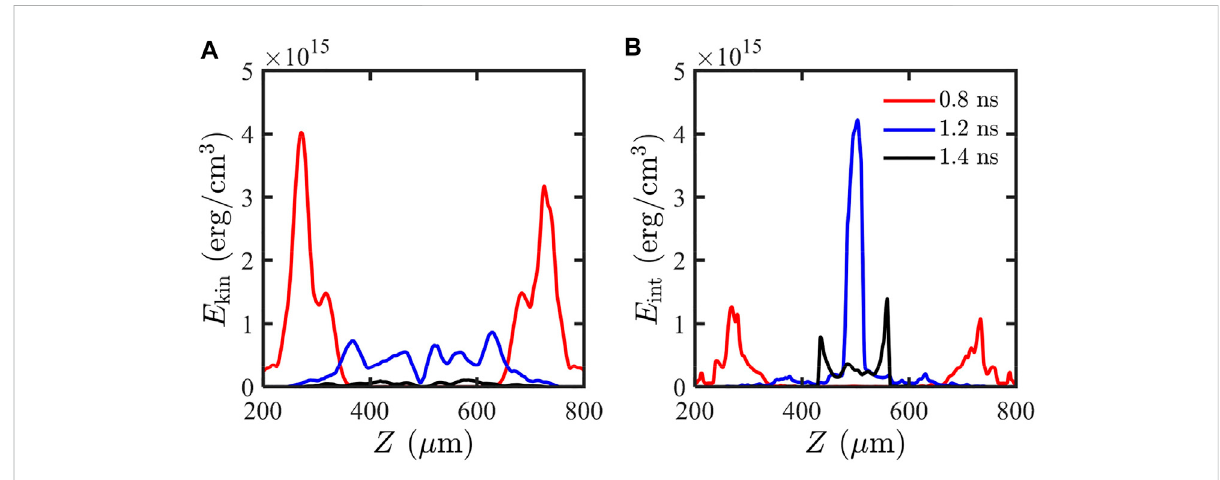
FIGURE 6 Distribution of kinetic energy density (A) and inertial energy density (B) at t (cid:2) 0 . 8ns (red line), t (cid:2) 1 . 2ns (blue line), and t (cid:2) 1 . 4ns (black line).